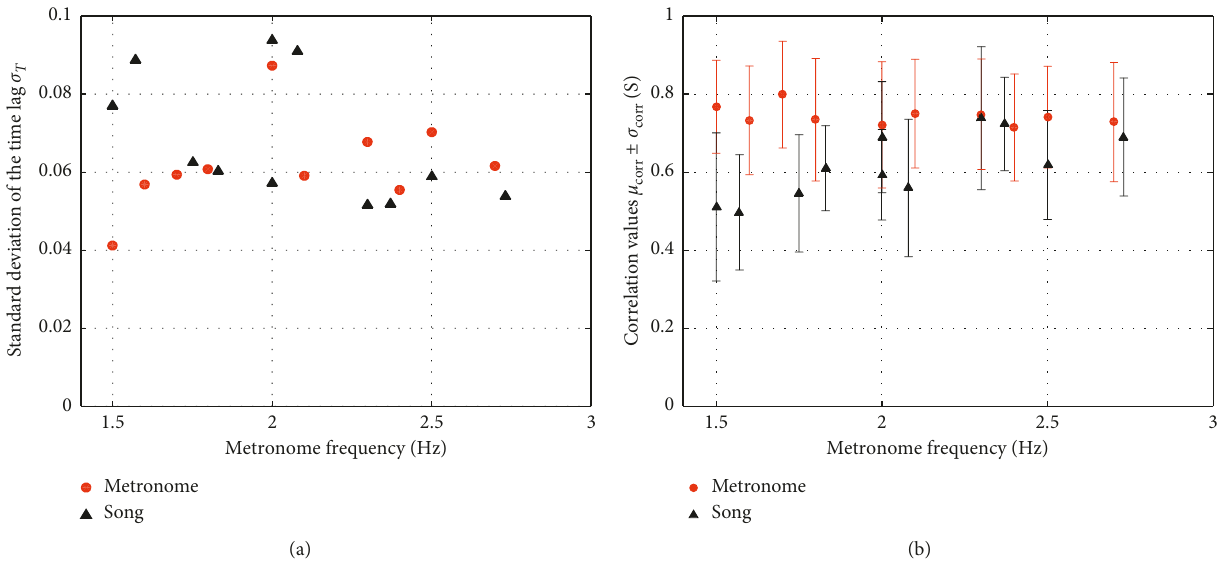
Figure 40: Comparison of the time lags (a) and correlation values (b) for auditory stimuli metronome and songs.